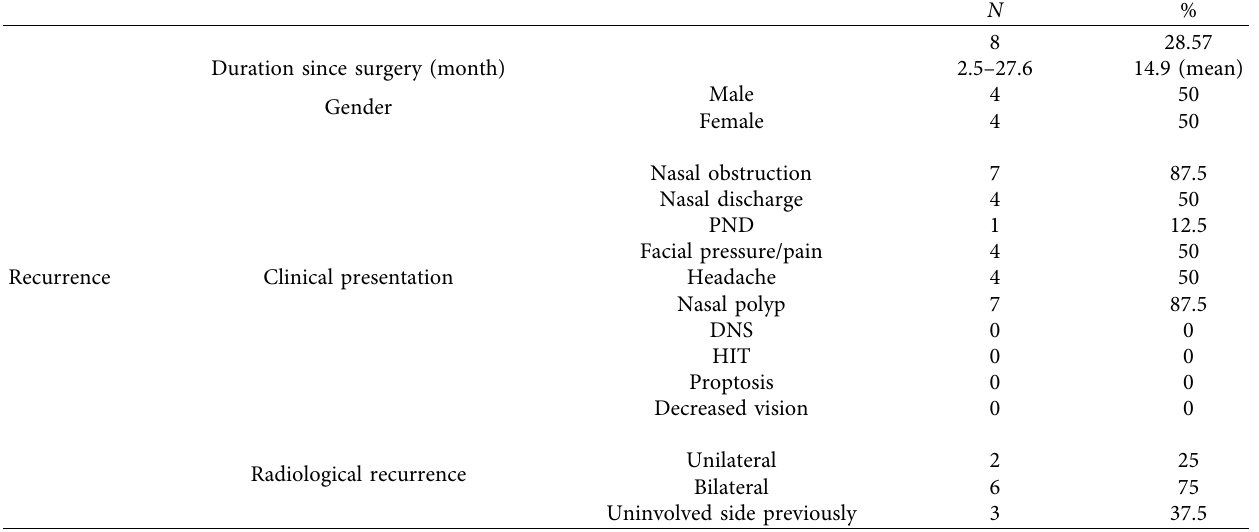
Table 5: Recurrence rate and characteristics.